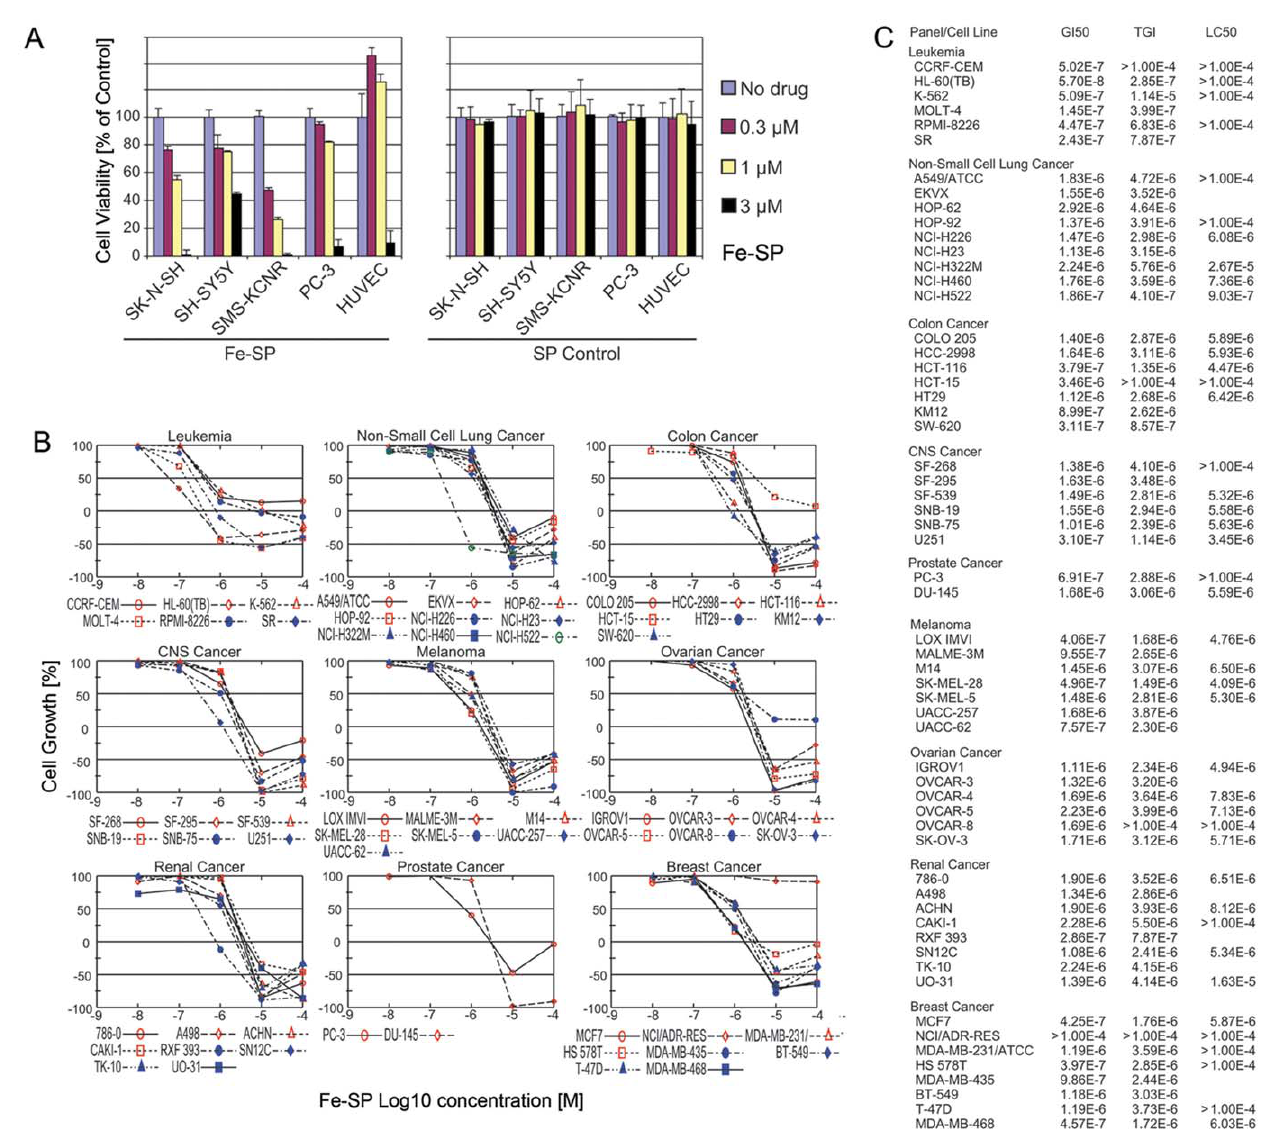
Figure 1. Comparative analysis of the cytotoxic effect of Fe-SP on NB and other cancer cell lines. ( A ) Viability of NB cell lines upon Fe-SP treatment. The cytotoxic effect of Fe-SP (0–3 m M) on human NB cell lines (SK-N-SH, SH-SY5Y, SMS-KCNR) was compared to a human cancer cell line of different origin (PC-3) and endothelial cells (HUVEC). Treatment with SP served as a negative control. The MTS viability assay was carried out as described (Materials and Methods). Data are expressed as the mean of the triplicate determinations (X 6 SD) of a representative experiment in % cell viability of untreated cells [100%]. ( B,C ) Differential effect of Fe-SP on cell growth in a NCI60 cancer cell line screen. Fe-SP effects were screened in a NCI60 cell line growth assay (http://dtp.nci.nih.gov/screening.html). Cells were treated in 96 well plates and cell growth of the TCA fixed treated and untreated cells assessed after 48 h.